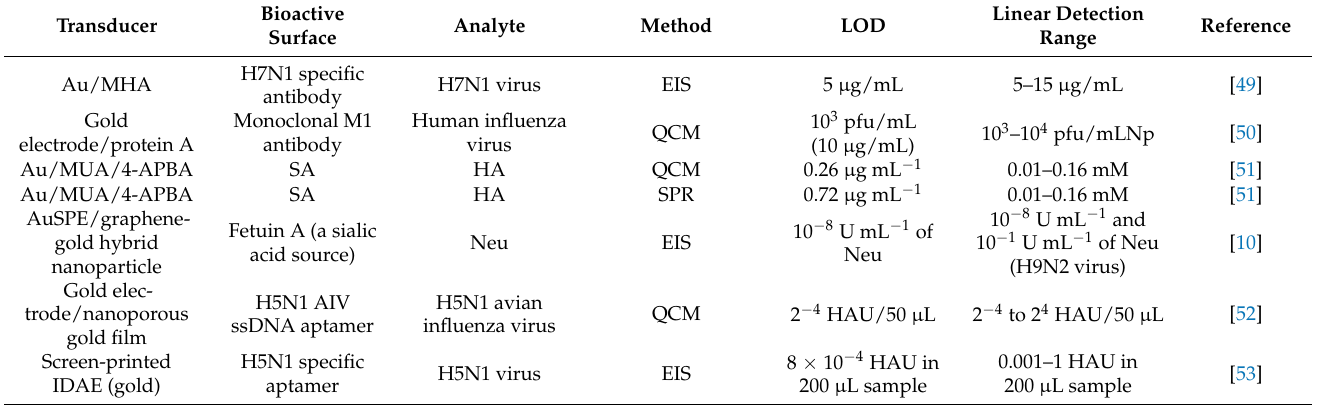
Table 1. Comparison of the developed anti-H1 immunosensor’s performance with similar influenza biosensors developed in recent years.